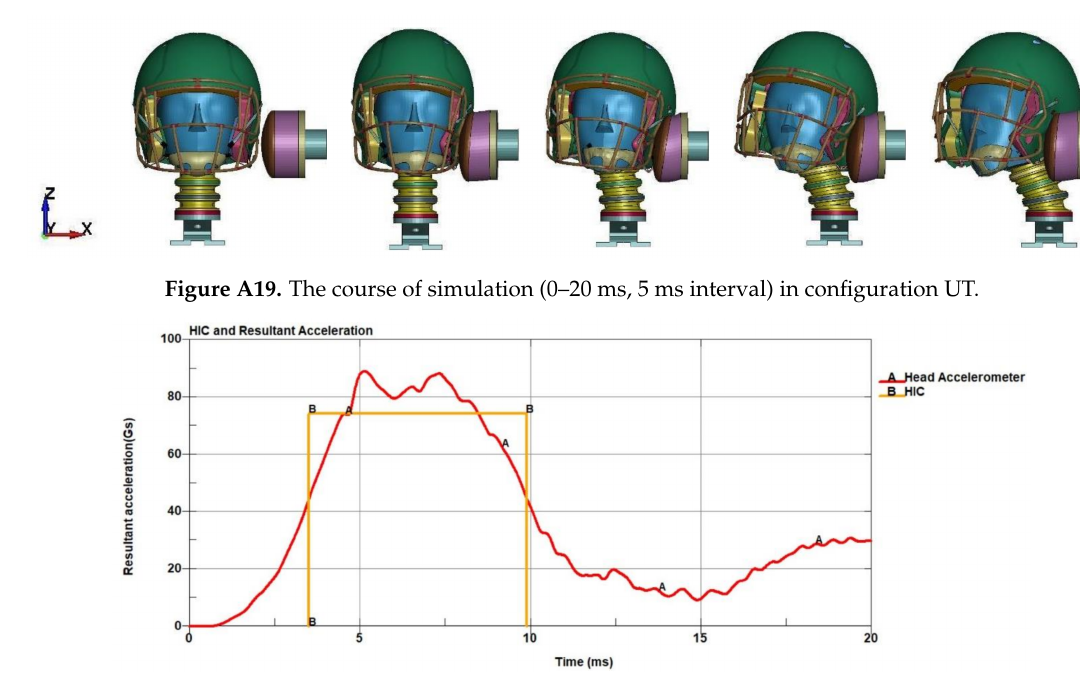
Brain Sci. 2021 , 11 , x FOR PEER REVIEW Figure A20. HIC and resultant acceleration (g) in time (ms) plot (HIC = 304).